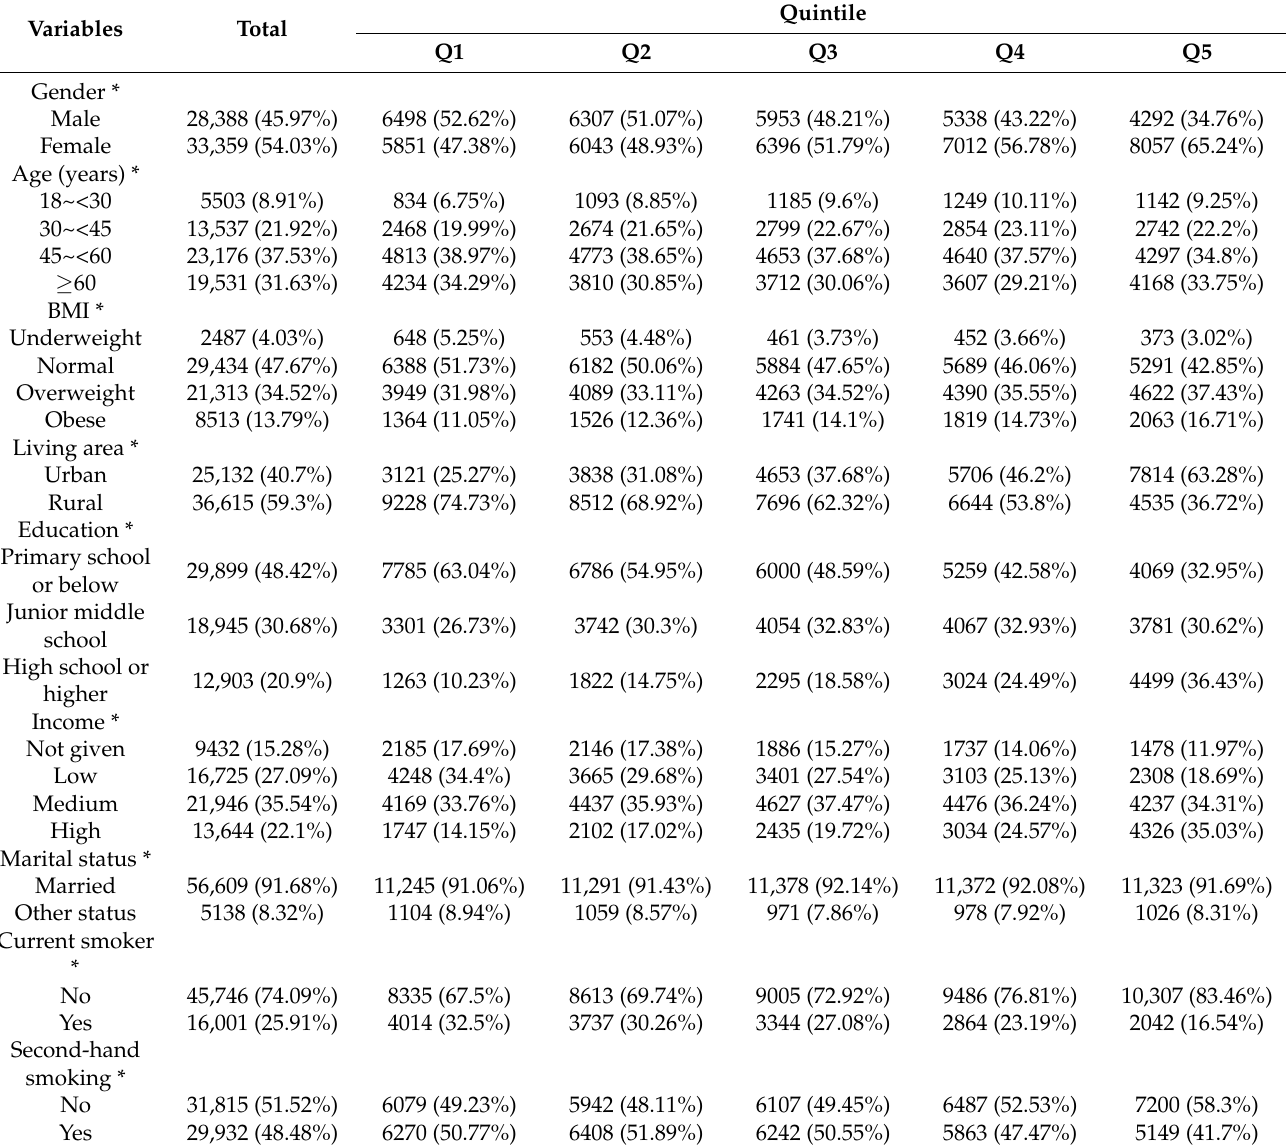
Table 1. Characteristics of participants by quintiles of BBP-diet